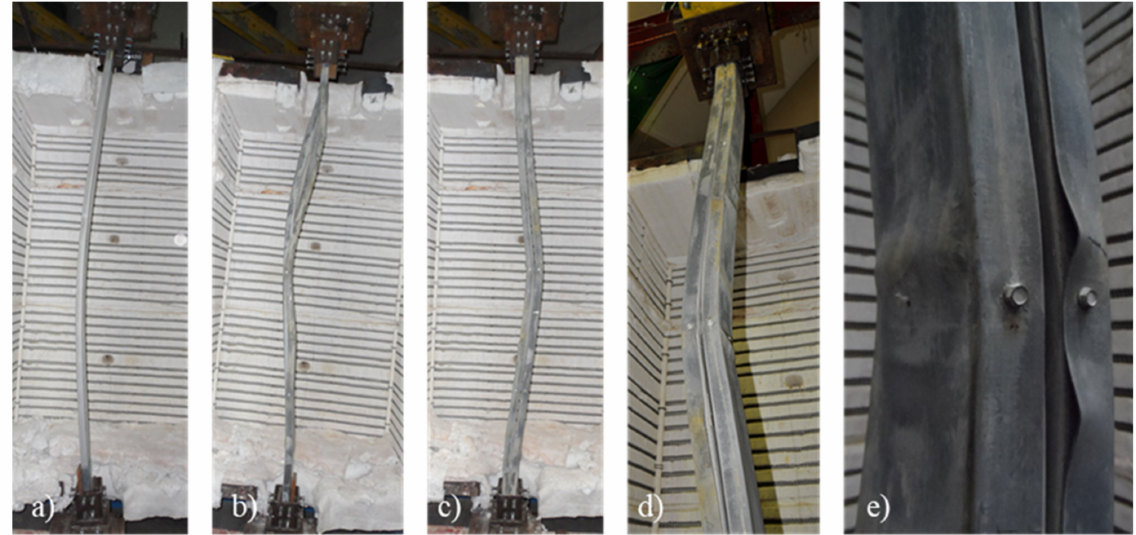
Figure 6. Observed failure modes. ( a ) R composite column with pinned boundary condition. ( b ) R composite column with fixed boundary condition. ( c – e ) 2R composite column with fixed boundary